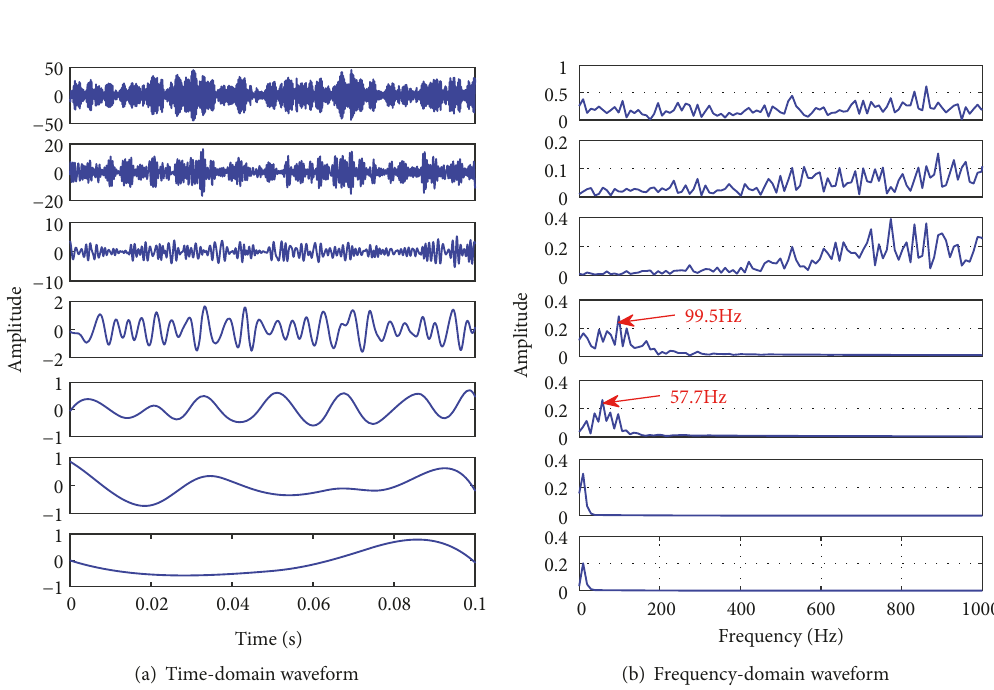
Figure 23: CELMD decomposition results of measured